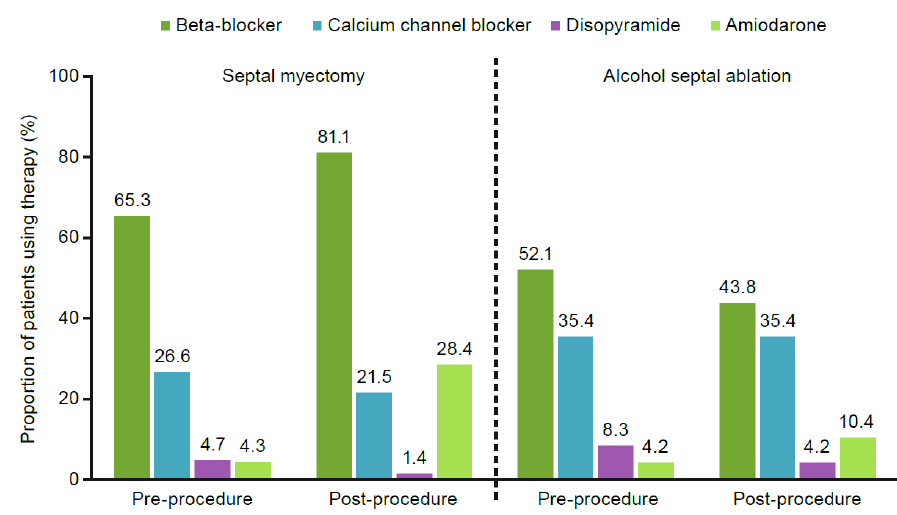
7 of 13 Figure 3. Patients with HCM-related outcomes. HCM: hypertrophic cardiomyopathy. 3.3. Septal Reduction Therapy Patients who underwent a septal myectomy or alcohol septal ablation ( n = 1985, 22.6%) had increased HCRU after the procedure. Before the procedure, the mean (± stand- ard deviation) number of HCM-related visits was 5.0 ± 5.2, compared with 6.6 ± 8.6 for post-procedure visits. Figure 4 reports the rates of drug therapy use before and after a myectomy or alcohol septal ablation. After undergoing a septal myectomy, the percentage of patients utilizing drug therapies increased: beta-blockers from 65.3% to 81.1%, and